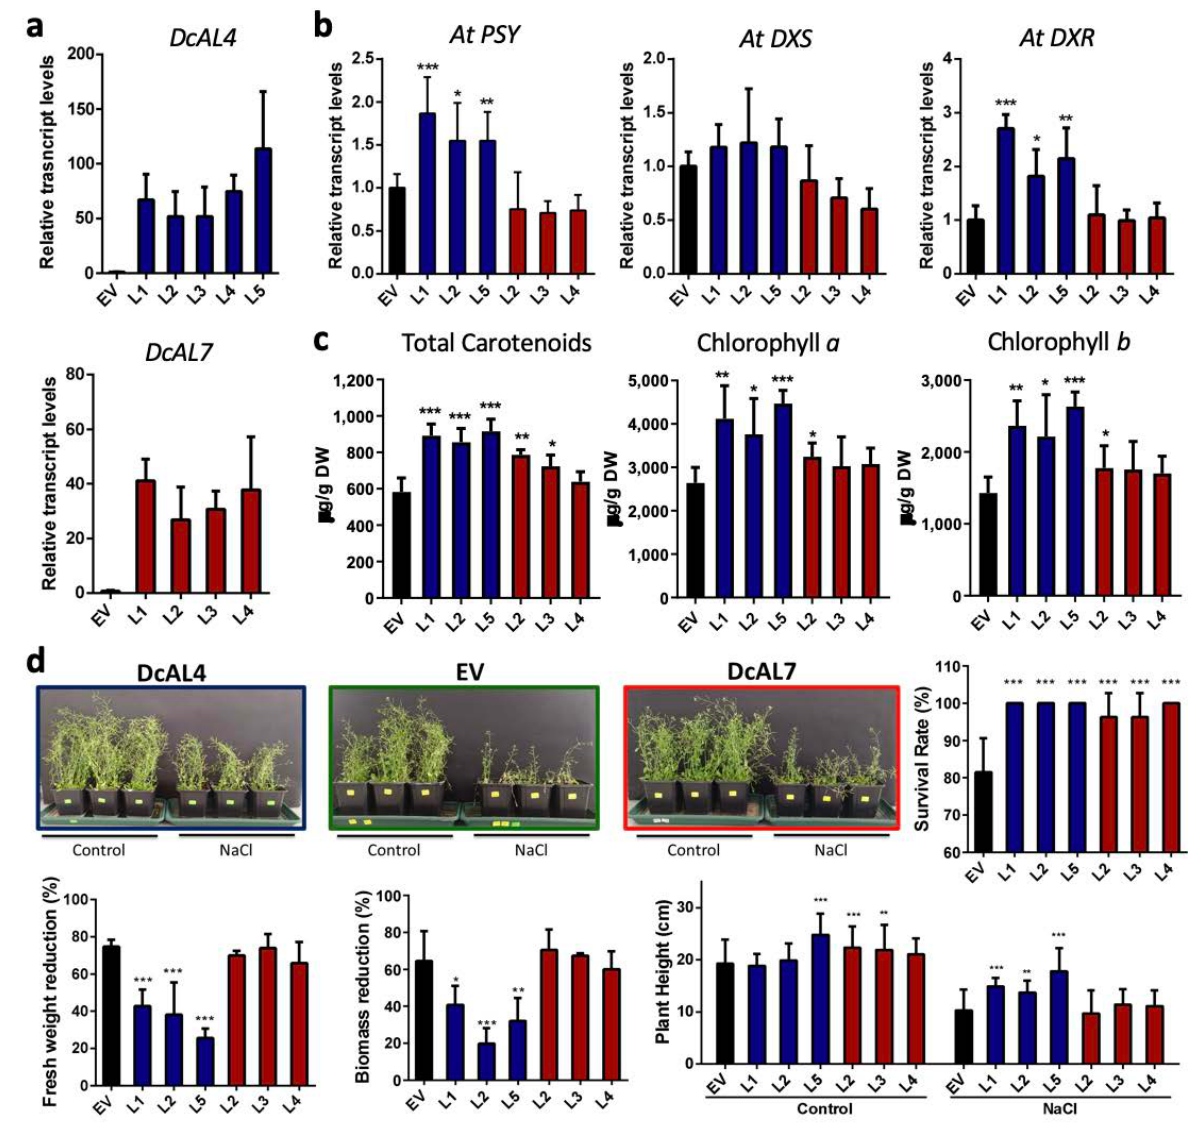
Figure 3. Effect of DcAL4 and DcAL7 ectopic expression in A. thaliana . ( a ) DcAL4 and DcAL7 relative transcript level in A. thaliana Al4 and Al7 T3 lines, respectively. ( b ) AtPSY , AtDXS and AtDXR relative transcript level in selected Al4 and Al7 T3 lines. ( c ) Carotenoid and Chlorophylls content in leaves of selected Al4 and Al7 lines. ( d ) Salt stress tolerance of A. thaliana transformed with DcAL4 and DcAL7. Representative image of EV, Al4 and Al7 lines subjected to salt stress treatment (see Supplemental Figure S4 for details of each line). Survival rate, fresh weight, biomass and plant height of EV, Al4 and Al7 lines submitted to salt stress treatment. For ( a , b ), transcript abundance was normalized to AtUbiquitin relative transcript levels and the Empty vector (EV) was used as calibrator. All values represent the means of three independent replicates (+SD). Statistically significant differences were determined by one-tailed ANOVA test (relative transcript levels and salt treatment) and by two- tailed unpaired T test (chlorophylls and carotenoids): * p < 0.05, ** p < 0.01, *** p < 0.001. Control: Well-watered plants; NaCl: 200 mM NaCl